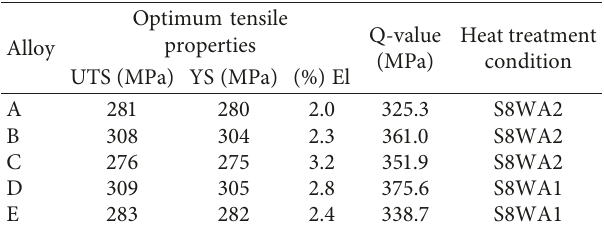
Table 4: Optimum high-temperature tensile properties and Q values for the alloys